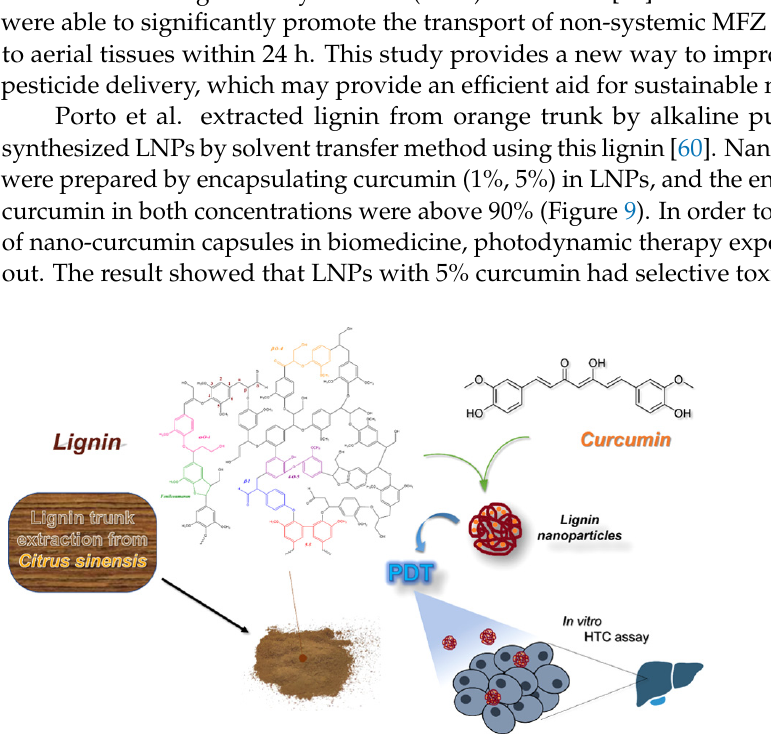
Figure 9. Illustrations of the preparation procedures of LNPs and application of cancer therapy. Reprinted with permission from Ref. [60]. Copyright 2021 American Chemical Society.